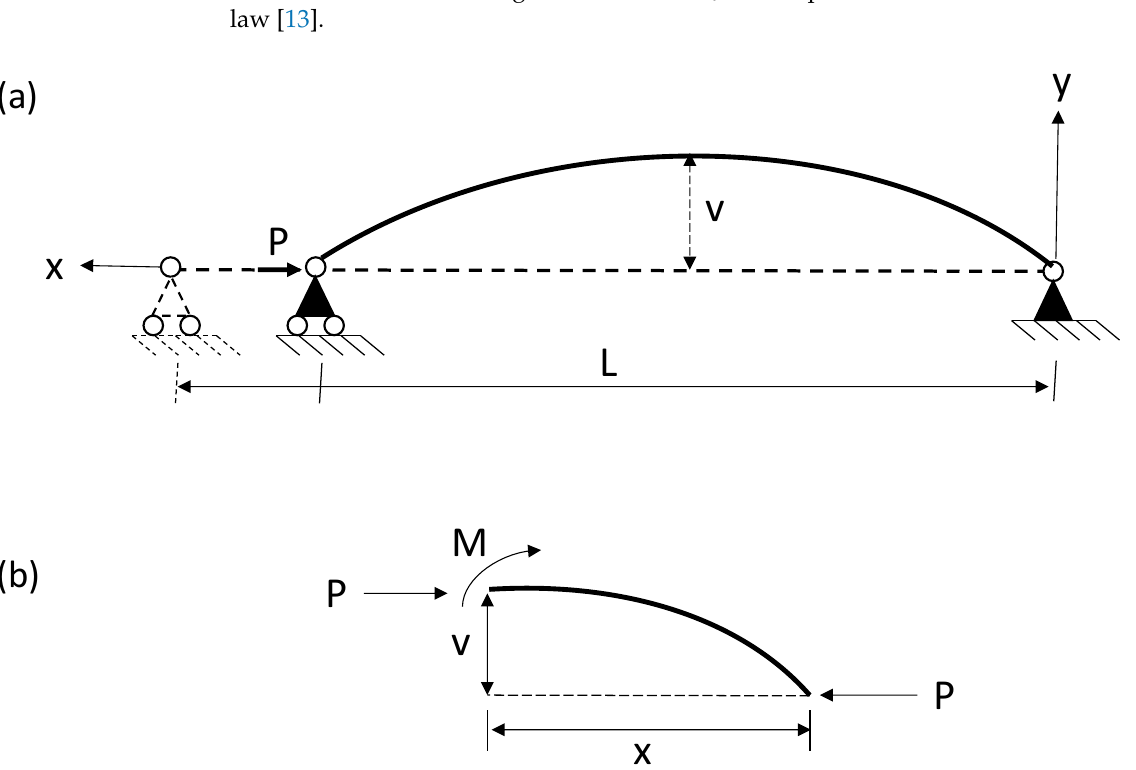
Figure 2. Column under uniaxial compression load with pinned–pinned boundary conditions, ( a ) deformed shape, ( b ) free-body diagram. M : the bending moment; x the longitudinal coordinate; P the axial load; and v the transverse displacement of the column.